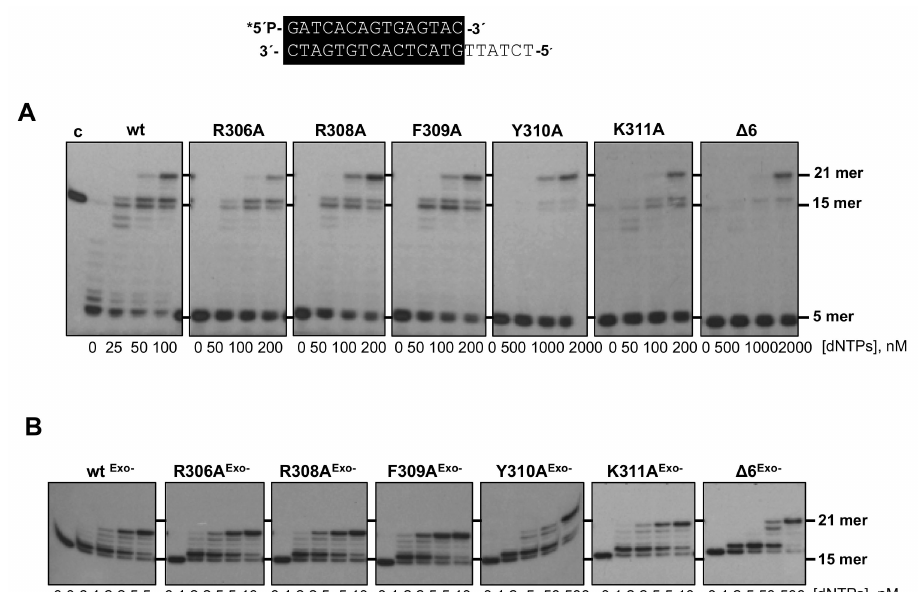
Figure 2. ( A ) DNA polymerase / exonuclease coupled assay. The assay was performed as described in Materials and Methods using the 5’-labeled primer / template molecule 15mer / 21mer depicted on top of the figure and the indicated concentration of dNTPs. Asterisk indicates the 32 P 5’-labeled end of the primer strand. Polymerization or 3’–5’ exonucleolysis is detected as an increase or decrease, respectively, in the size of the primer (15mer). ( B ) DNA polymerization catalyzed by wild-type Exo- (D12A / D66A) [18], R306A Exo- , R308A Exo- , F309A Exo- , Y310A Exo- (Y310A / D12A / D66A), K311A Exo- , and ∆ 6 Exo- DNA polymerases. The assay was performed as described in ( A ), using the 5’-labeled molecule 15mer / 21mer and the indicated concentration of dNTPs as substrate; c: control